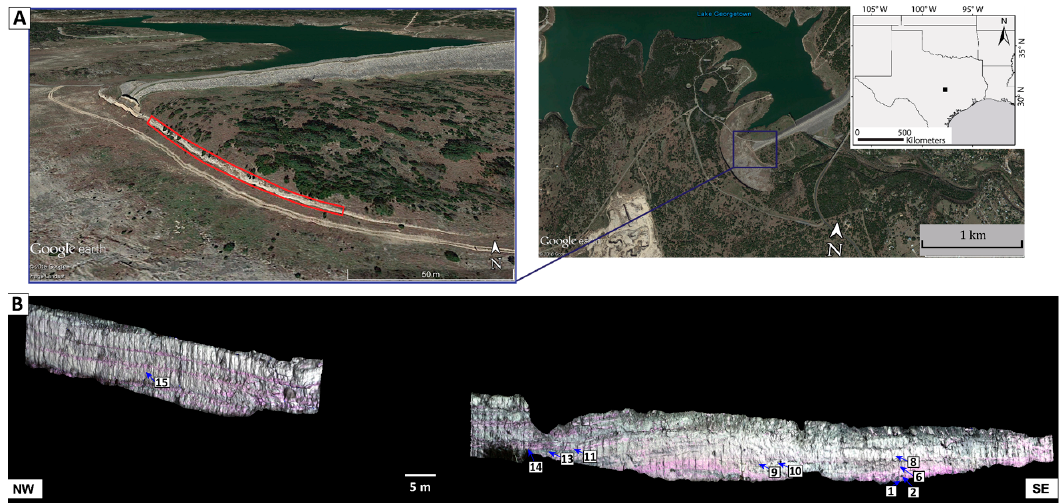
Figure 1. ( A ) Study location in Google Earth, modified from [33]. ( B ) Rock chip sample locations along